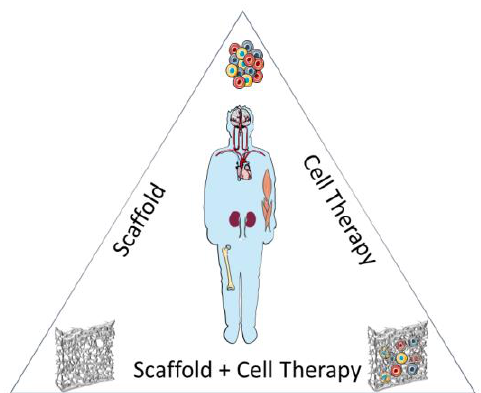
Figure 1. Depiction of the current clinical/therapeutic approaches to tissue regeneration: cell-based therapies, implantation of synthetic scaffolds to repair and combination of a scaffold with seeded cells.